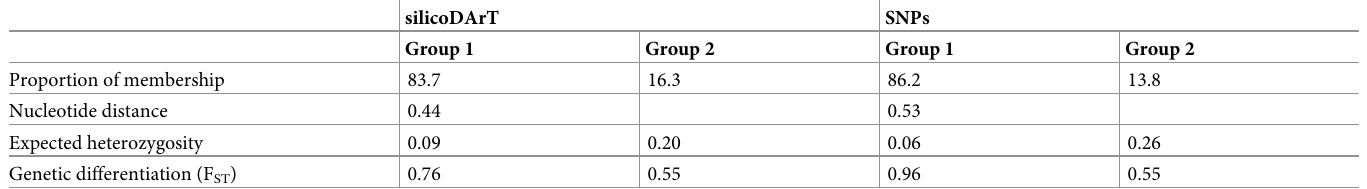
Table 2. Genetic divergence among (net nucleotide distance) and within (expected heterozygosity) populations, and the proportion of membership of the popula- tion samples based on silicoDArT and SNP markers.